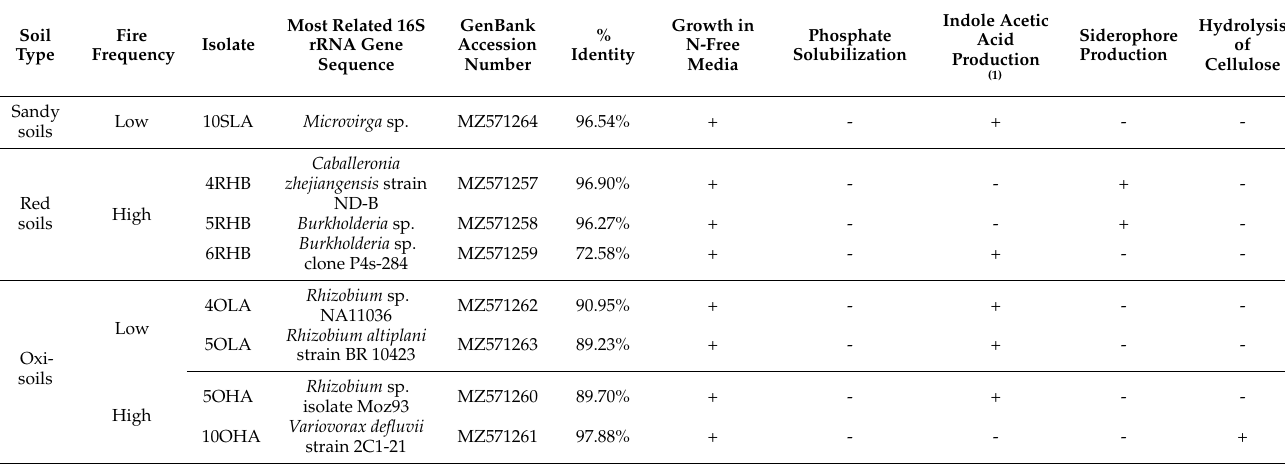
Table 2. Taxonomical identification of soil isolates from NSR soils and related phylum according to the most related source organism deposited in GenBank. Population codes follow Figure 1. GenBank accession numbers indicate the sequences generated in this